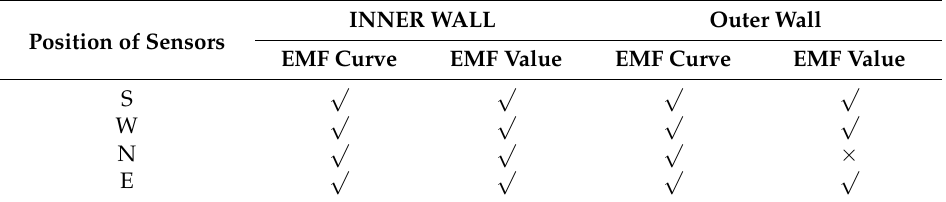
× : Dis-similar to the Figure 10 distribution.